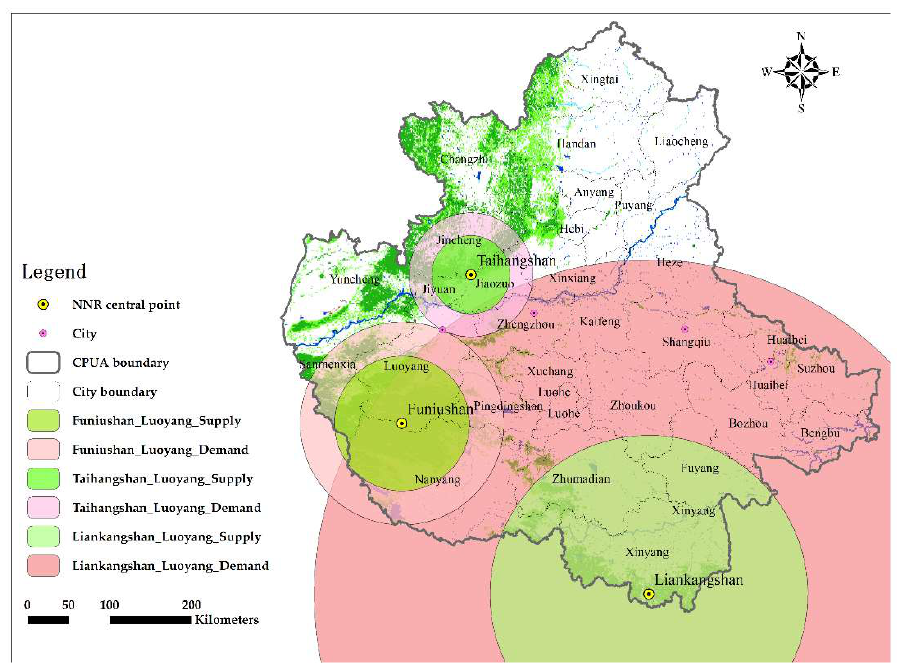
Figure 3. ES supply and demand patterns based on spatial transfer from ecospace to Luoyang.